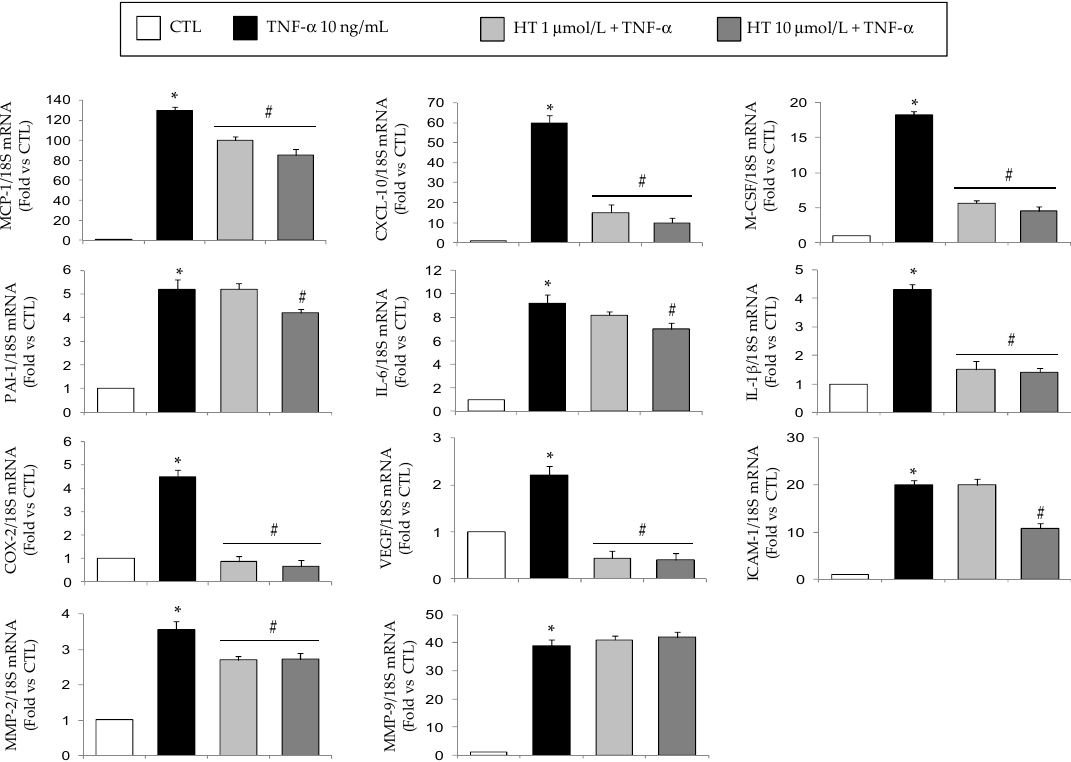
Figure 1. Modulation by HT of mRNA expression levels of genes associated with adipocyte inflammation. Simpson–Golabi–Behmel syndrome (SGBS) adipocytes were pretreated with HT (1 h) at the concentrations indicated, and then treated with 10 ng / mL TNF- α for 18 h. Total RNA was extracted from cells, and mRNA levels of the indicated genes were measured by qPCR using specific primers and probes and normalized to 18S RNA. Data (means ± SD, n = 3) are expressed as fold induction over untreated control (CTL). * p < 0.05 vs. CTL. # p < 0.05 vs. TNF- α alone.